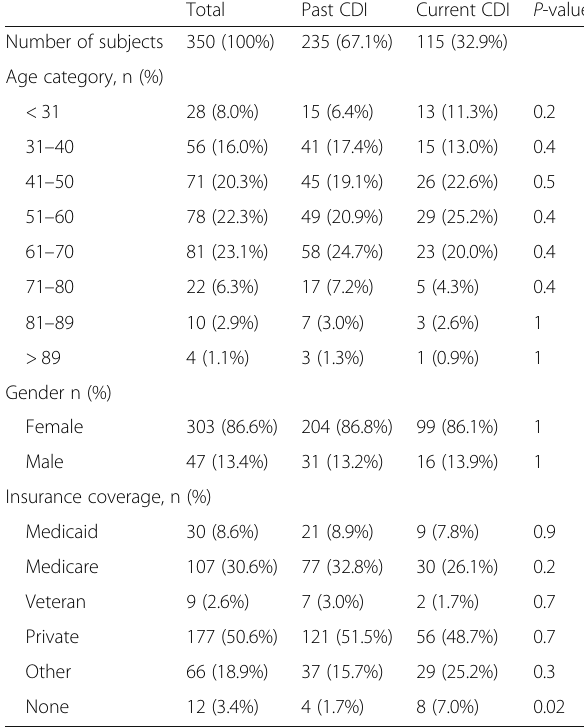
Table 2 Characteristics of participants ’ Clostridioides